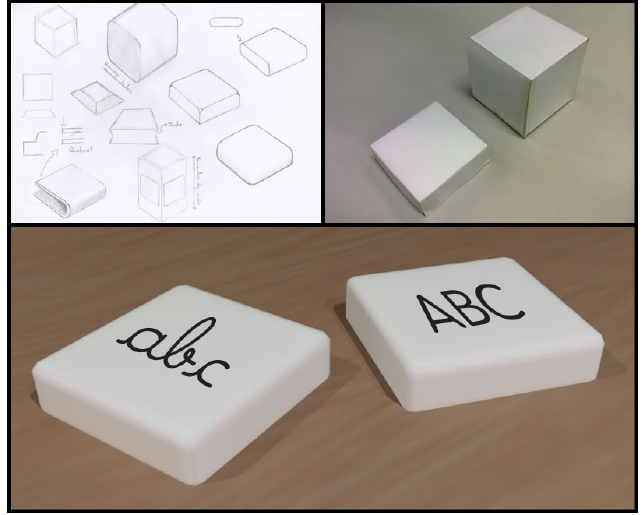
Fig. 3. Initial sketches, paper mock-ups and final solution rendered with a 3D modeling